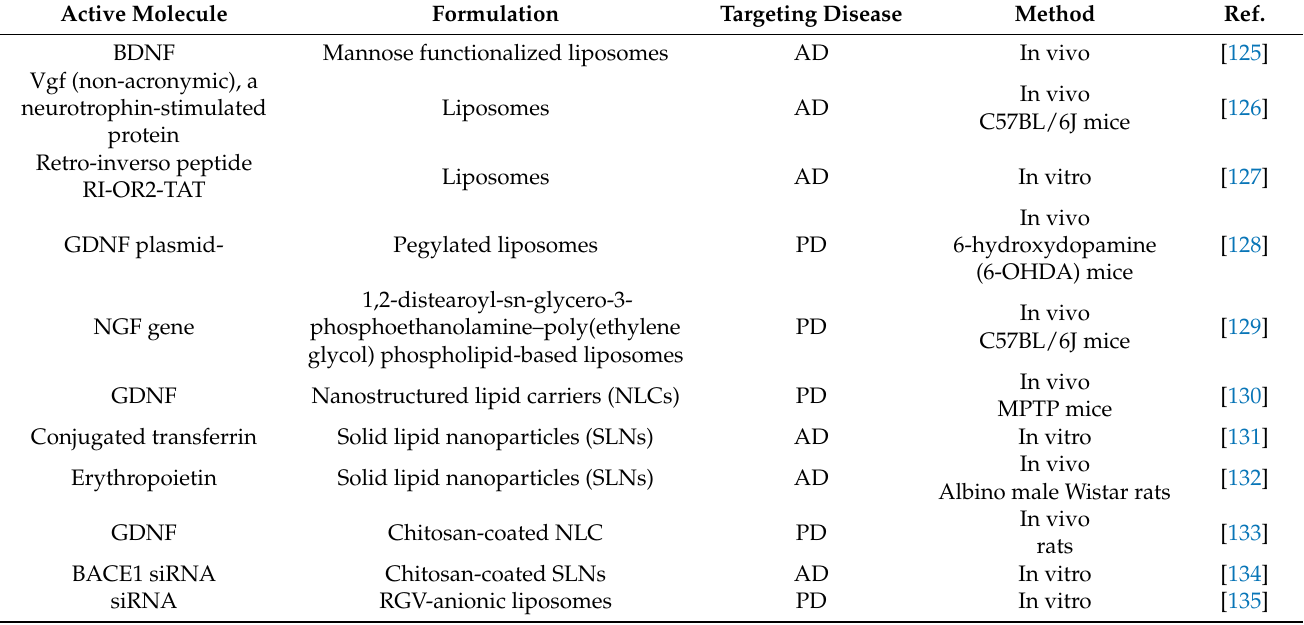
Table 2. Pharmaceutical formulations with proteins and genes targeting neurodegenerative disorders using lipid-based and inorganic nanoparticles.